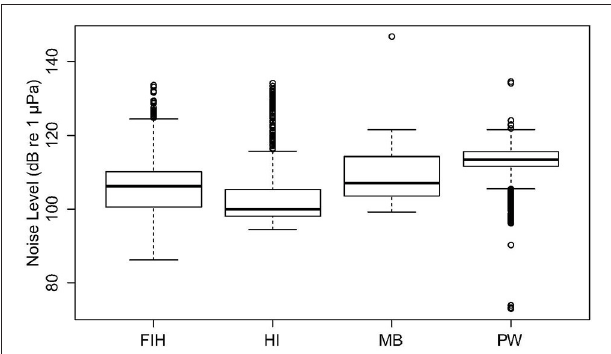
FIGURE 5 | Overall broadband noise levels (NL_BB) of four Swan River sites: Fremantle Inner Habour (FIH), Heirisson Island (HI), Matilda Bay (MB) and Perth Waters (PW).